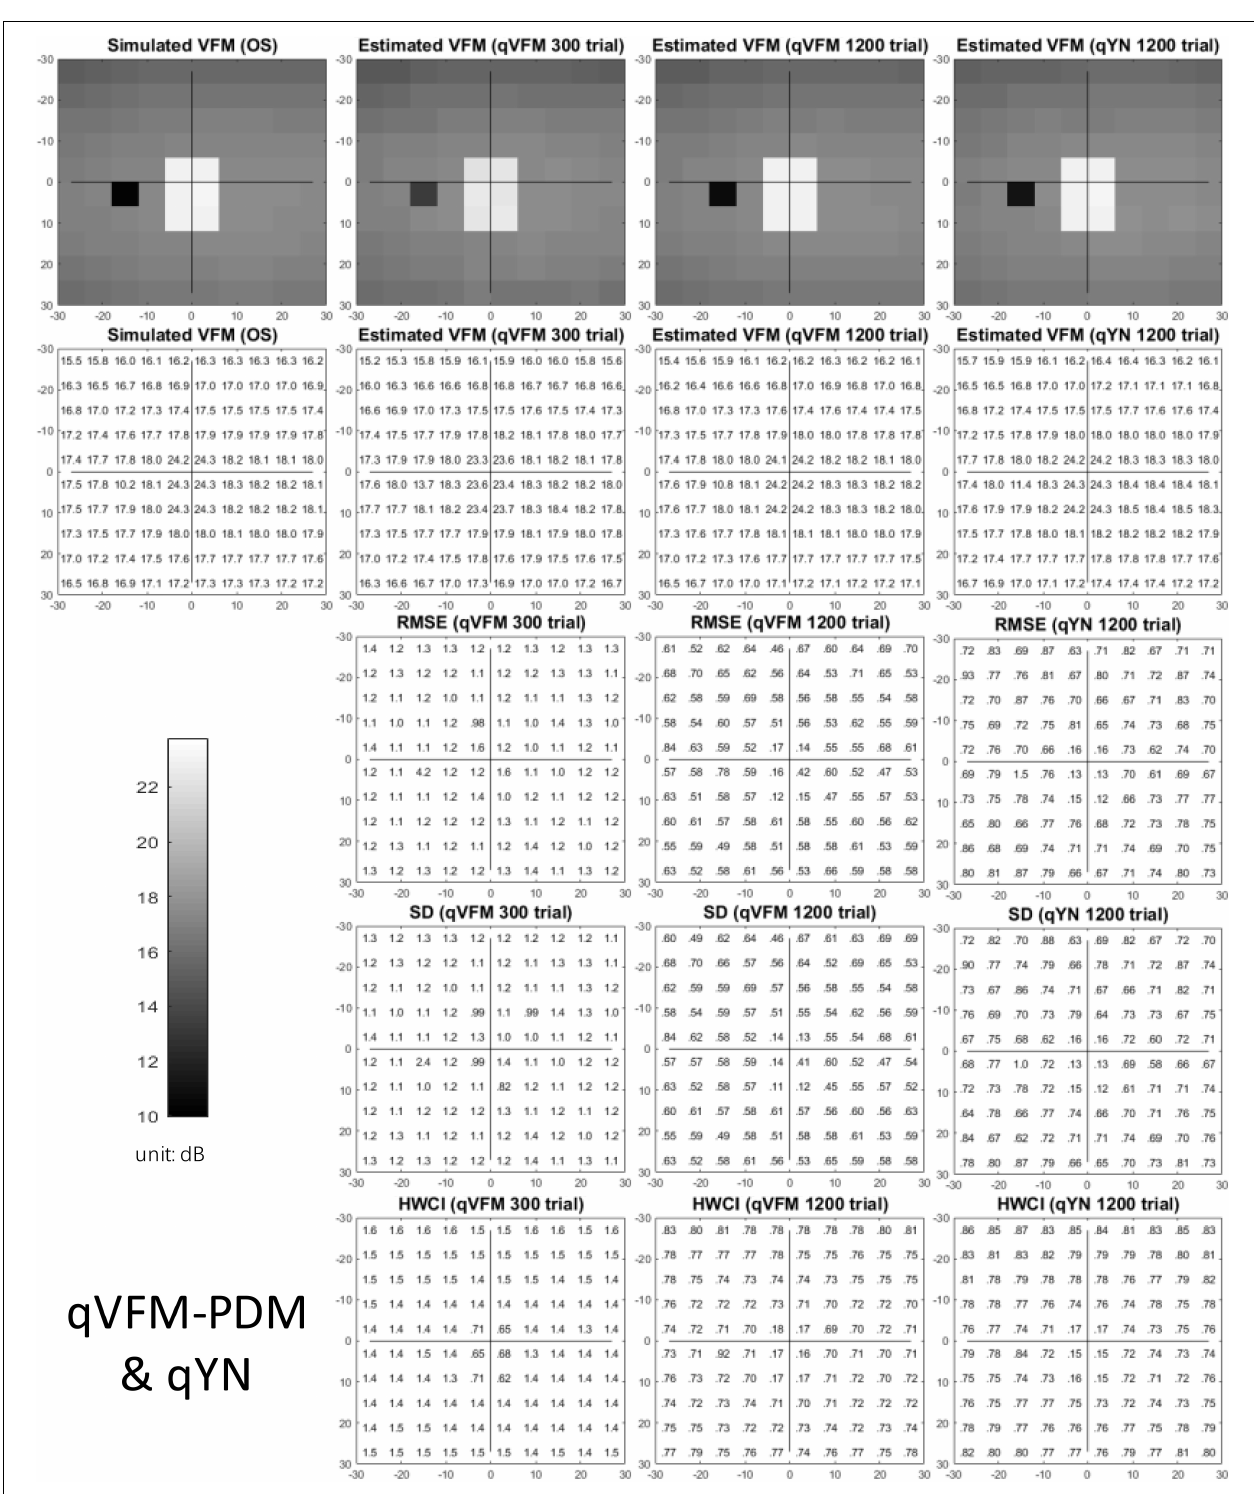
Frontiers in Neuroscience |